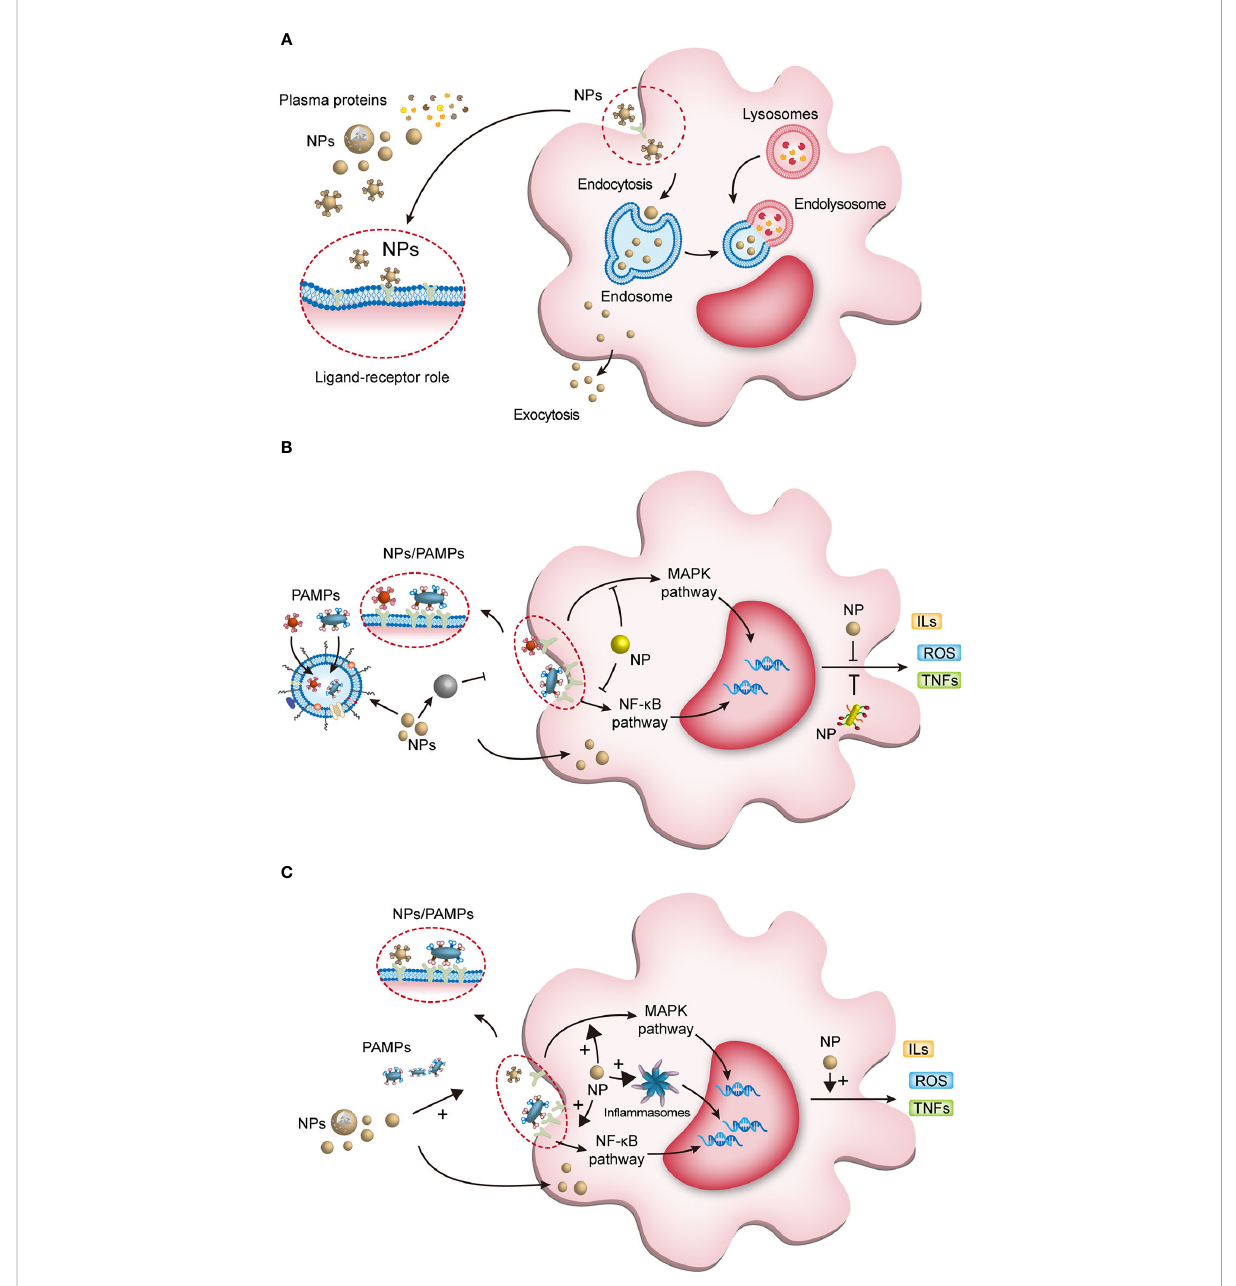
FIGURE 2 The interaction of NPs with macrophages and NPs modulating macrophage anti/pro-in fl ammatory function. (A) Once NPs enter the body, they bind to plasma proteins and enter macrophages. Some endosomes containing NPs degrade the processed NPs and release them extracellularly to exert active effects; the other endosomes fuse with lysosomes to form endolysosomes, which exert intracellular effects. (B) First, NPs can eliminate macrophage activation by phagocytosis and con fi nement of pathogen-associated molecular pattern molecules (PAMPs); second, they inhibit PAMPs interacting with pattern recognition receptors (PRRs); third, NPs entering the cytoplasm inhibit the transduction of in fl ammatory signaling pathways; and fi nally, NPs inhibit the release of active products of in fl ammatory pathways and control the cell and tissue damage caused by overactivated macrophages. (C) NPs modulate macrophage proin fl ammatory activity. NPs can enhance PRR activation to initiate macrophage in fl ammation. After entering the cytoplasm, NPs activate downstream pathways and in fl ammasomes to induce proin fl ammatory factor production. NPs, nanoparticles; PAMPs, pathogen-associated molecular pattern molecules; ROS, reactive oxygen species; ILs, interleukins; TNFs, tumor necrosis factors; MAPK, mitogen-activated protein kinase; NF- k B, nuclear factor-kappa